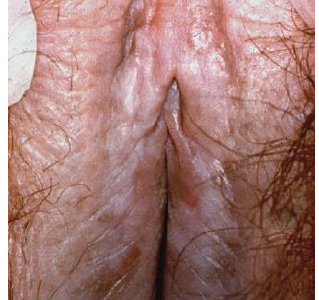
Figure 8. Lichen sclerosus.